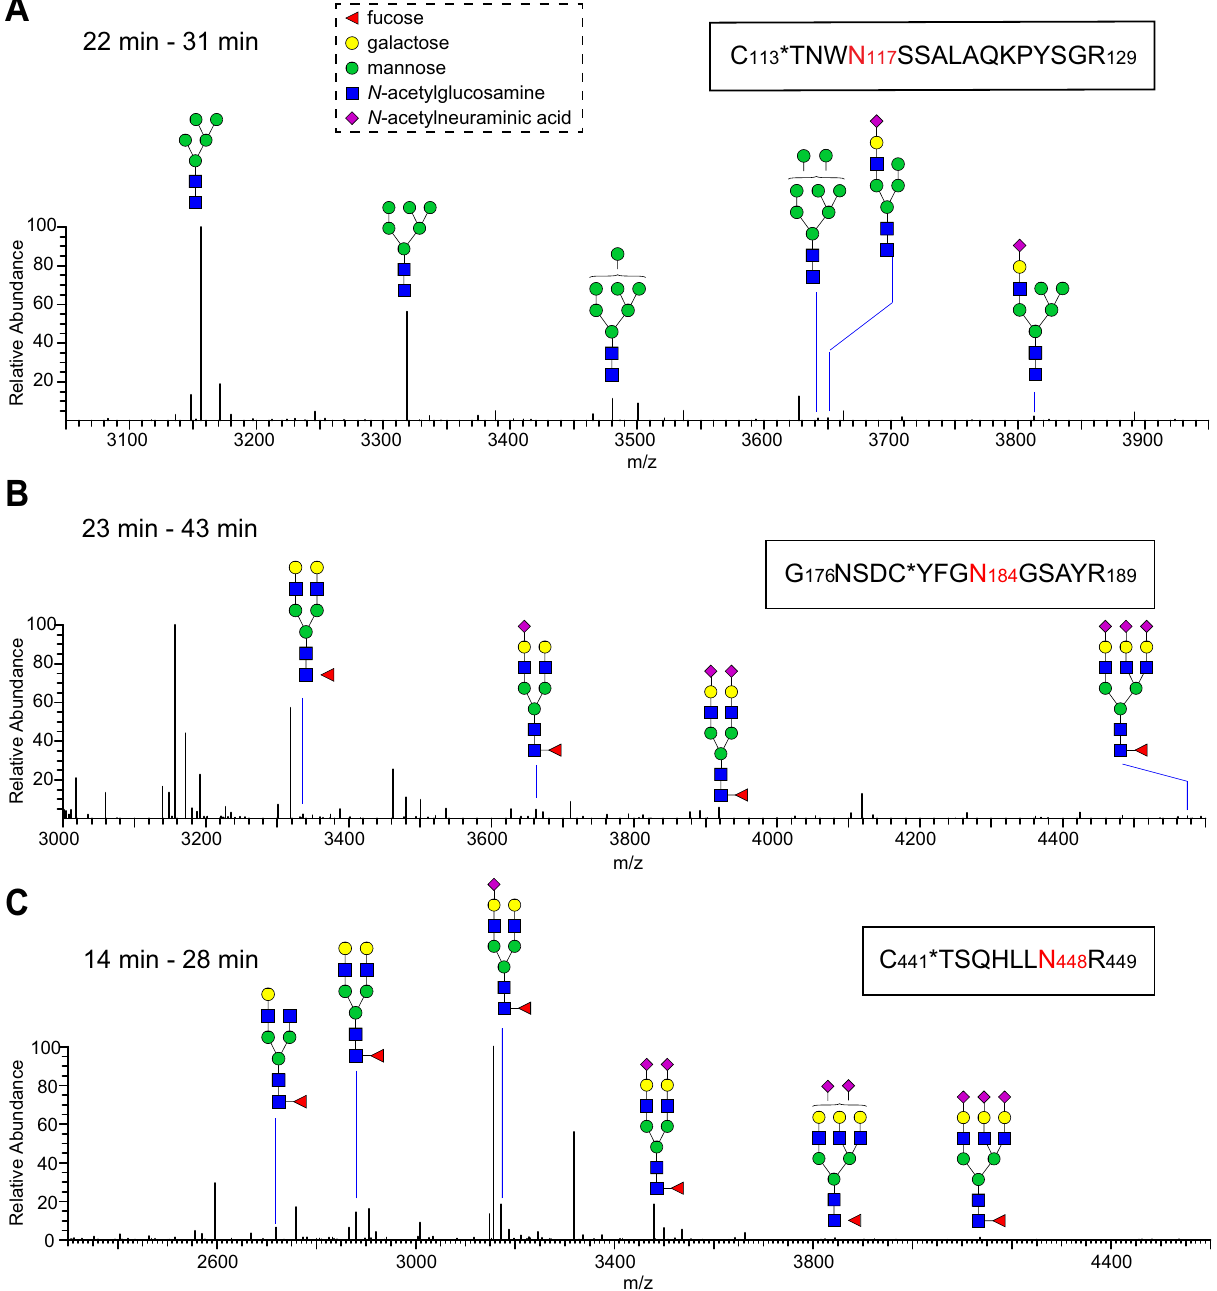
Figure 6. Major N-glycan species detected at the three glycosylation sites of native tPA. Native tPA was digested with trypsin and endoproteinase GluC to obtain glycopeptides (N-glycosylation site highlighted red in sequence). Full MS spectra were averaged across the time region in which the target glycopeptides eluted during the LC–MS run and deconvoluted for charge state. The glycoform profile for the three N-glycosylation sites of tPA are shown: N117 ( A ), N184 ( B ), N448 ( C ). The N117 site carries primarily high-mannose and hybrid type glycans, while complex N-glycans were most abundant at the N184 and N448 sites. Monosaccharides are represented using the Symbol Nomenclature for Glycans [dashed box in panel (A)]. See Supplementary figure 2 for the peptide glycoforms detected on recombinant